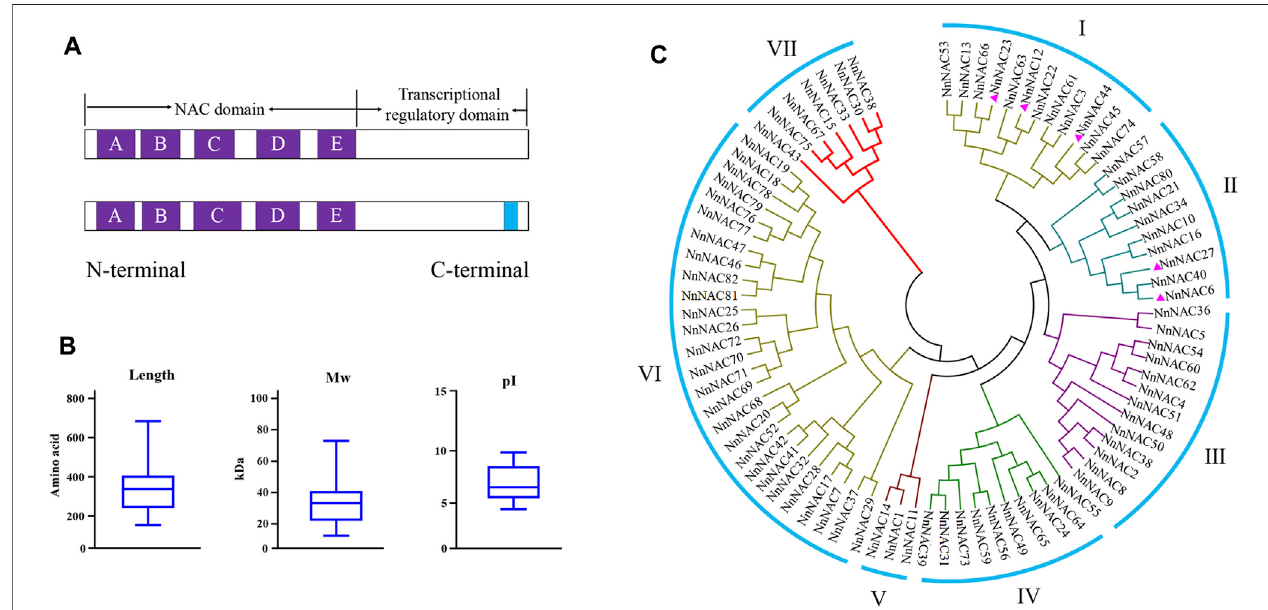
FIGURE1| NACdomains,proteinsequencefeaturesandphylogeneticanalysisinlotus. (A) SchematicrepresentationofthehighlyconservedNnNACkeydomain and subdomains A – E (purple squares) at the N-terminal. The blue square represents the transmembrane motif (TM). (B) Box plots showing statistical distribution of amino acid sequence length, molecular weight (Mw) and isoelectric point (pI) of NnNACs. (C) Phylogenetic clustering of 82 identi fi ed lotus NAC proteins. The purple triangle represents NnNAC protein harboring the TM motif.